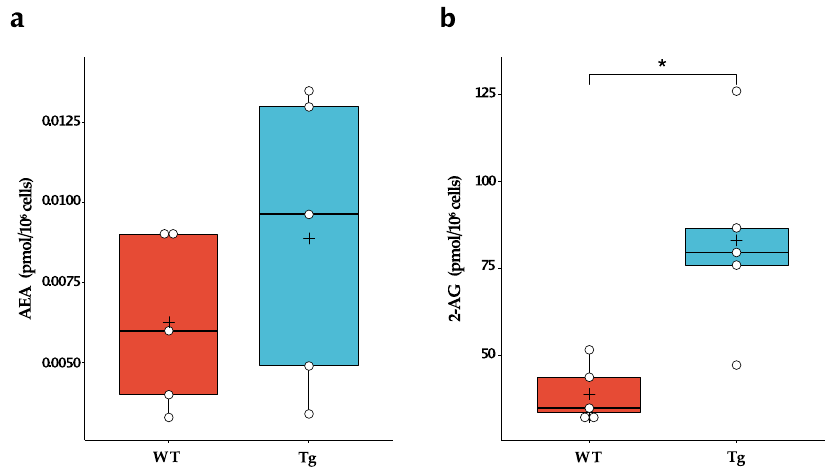
Figure 1. Endogenous levels of endocannabinoids in wild-type (WT) and Tg2576 (Tg) microglia. ( a ) AEA and ( b ) 2-AG basal levels in WT and Tg microglia were quantified by liquid chromatography- mass spectrometry. Horizontal line and + within the rectangle (boxplot) represent the median and the mean, respectively, of the values of five independent experiments (white circles). Significance is shown as p value, calculated using an unpaired t -test. * p < 0.05.